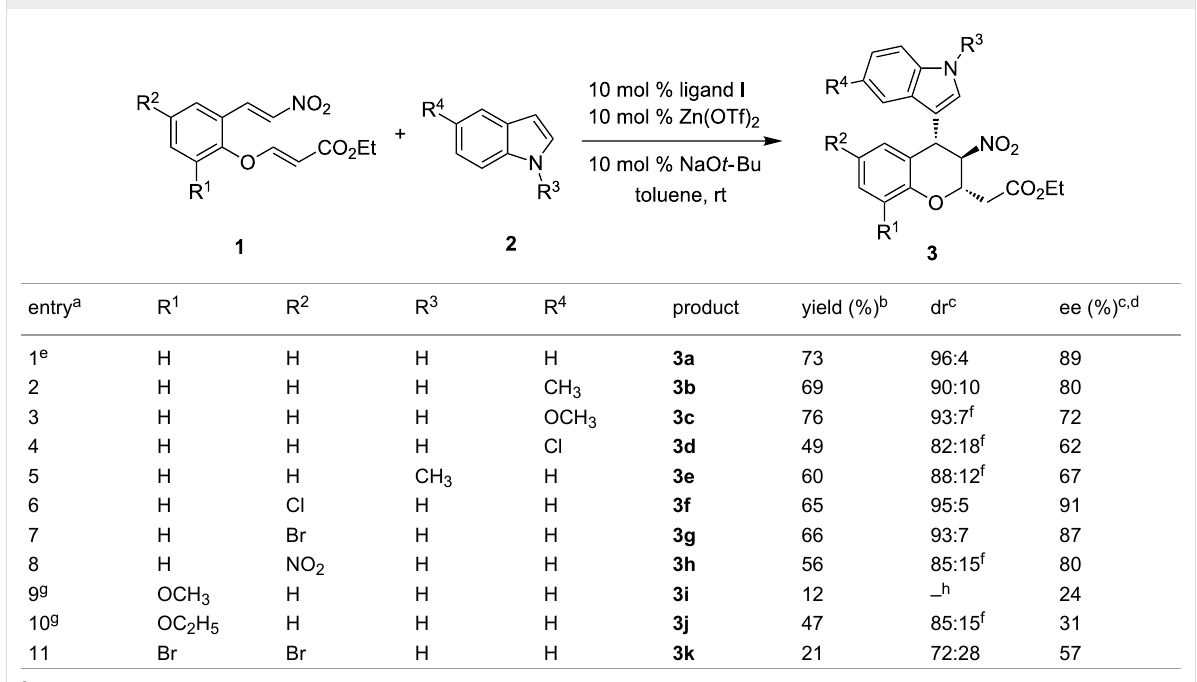
Table 4: Asymmetric tandem Friedel–Crafts alkylation/Michael addition reaction of nitroolefin enoates with indoles.